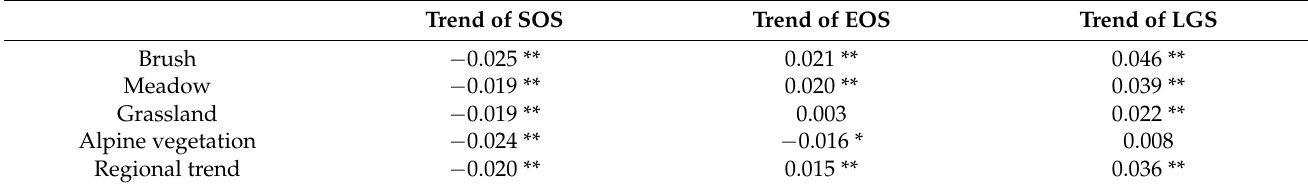
Table A2. The phenology trend of different vegetation types in the Qilian Mountains. Trend of